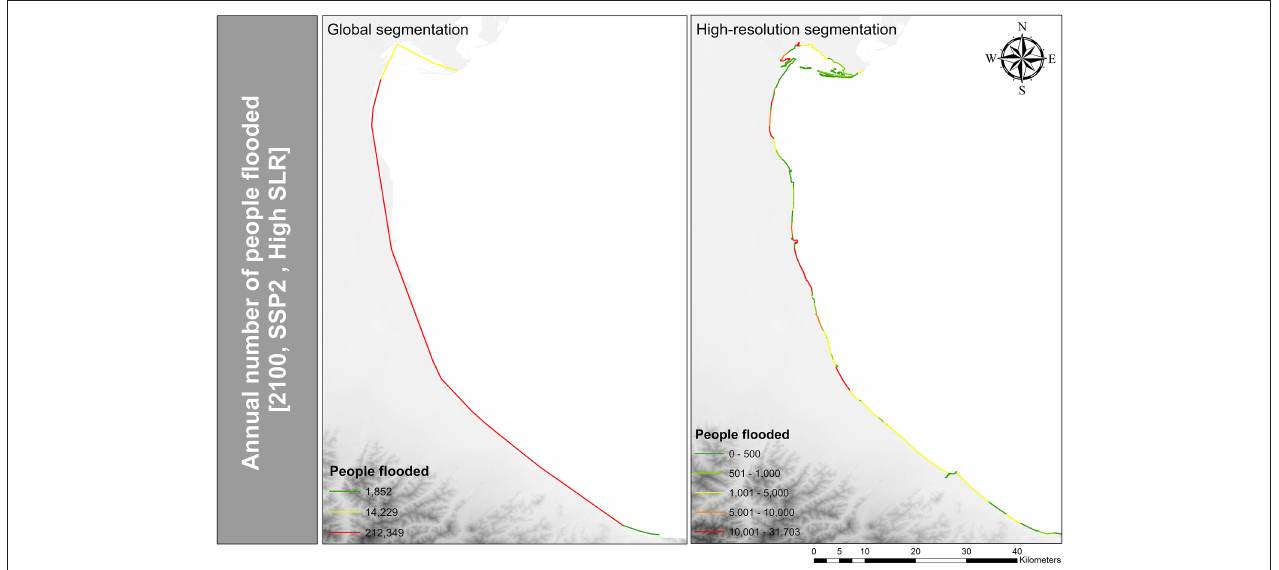
FIGURE 7 | Comparison of the spatial distribution of the expected number of people flooded annually using the global and high-resolution segmentation in 2100 (SSP2, High SLR).